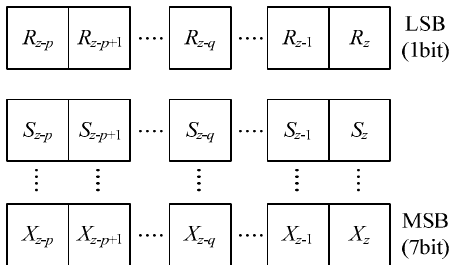
Figure 2. Generation method of pseudorandom numbers based on maximal length sequence.